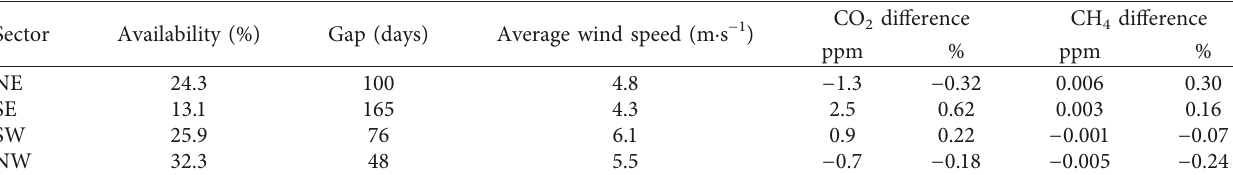
Table 6: Differences between average concentrations calculated for different sectors and from observations during the night, together with their corresponding availabilities, numbers of days without observations (gaps), and average wind speed at the site.